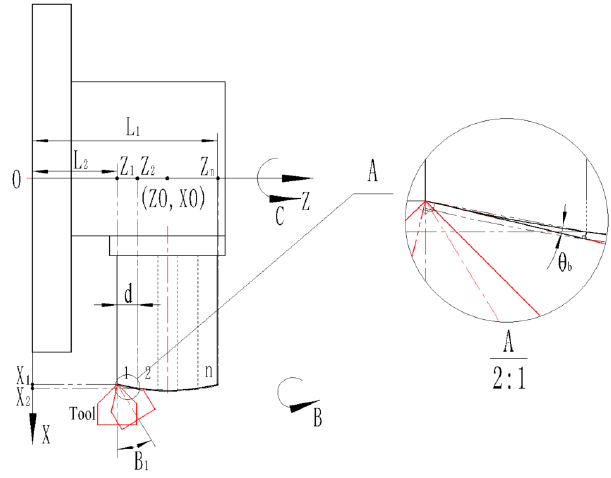
Figure 7. Processing schematic with